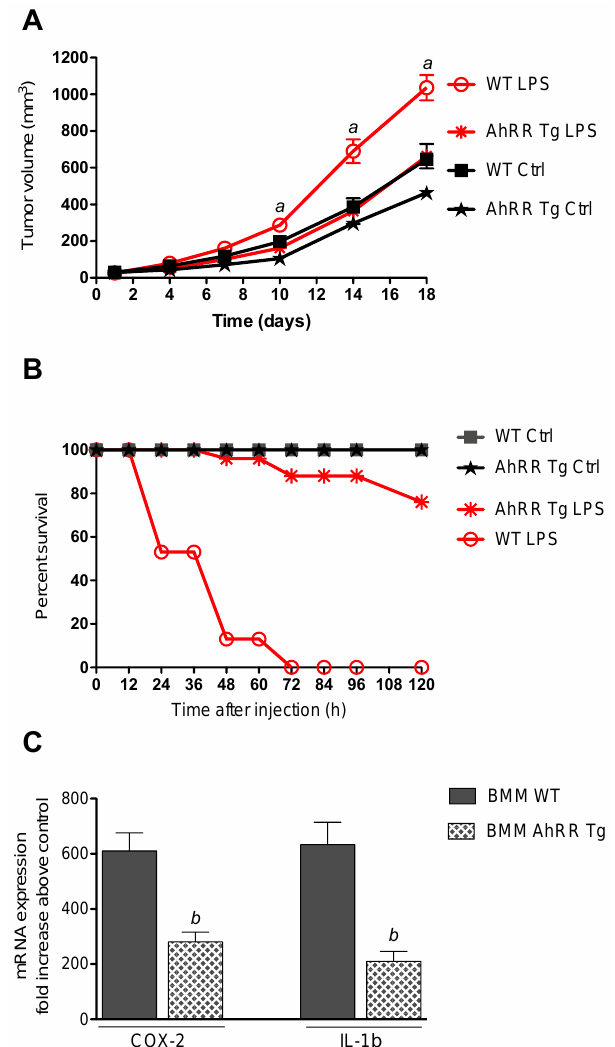
Figure 2. Resistance of AhRR Tg mice to LPS. ( A ) Suppressed growth of LPS-induced tumor volume of EL4 lymphoma cells in AhRR Tg mice. WT and AhRR Tg mice were treated i.p. with a single injection of LPS (2.5 mg / kg bw; red lines). Tumor volume was measured over a period of 18 days. Means of tumor volume are shown. a significantly higher than LPS-treated AhRR Tg and WT Ctrl mice ( p < 0.01). ( B ) 6-week-old male AhRR Tg mice and littermate WT mice ( n = 8 for each group) were i.p. injected with 25 mg / kg of LPS (red lines) or with the vehicle control PBS (black lines). Lethality was observed over 120 h after LPS challenge. ( C ) AhRR suppresses LPS-induced expression of IL-1 β and COX-2 in BMM. BMM derived from WT and AhRR Tg mice were treated with 100 ng / mL LPS for 24 h and mRNA was analyzed by qPCR. b significantly lower than LPS-treated BMM WT ( p < 0.005).